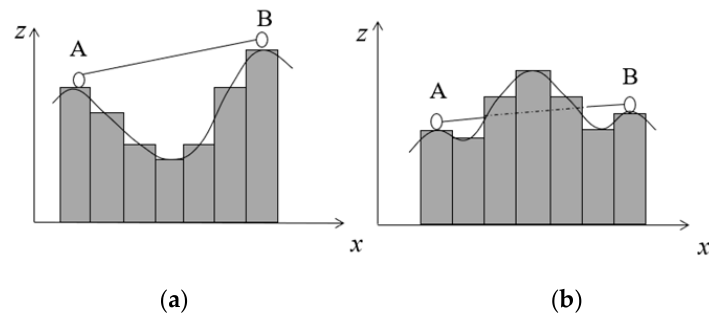
Figure 1. Topographic line-of-sight analysis: ( a ) visible; ( b ) invisible.